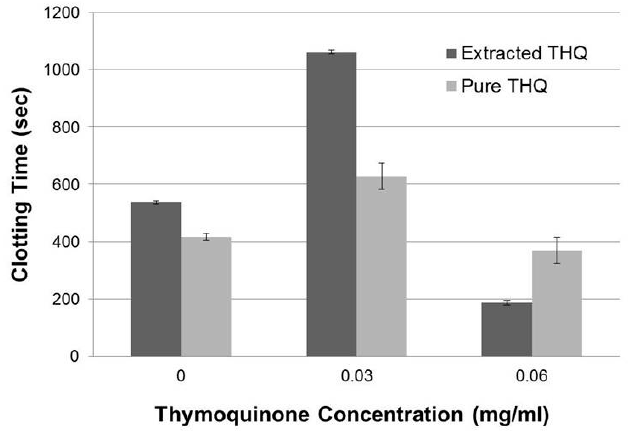
Figure 2. THQ extracted from black seeds and pure THQ exhibit a moderate to slight increase in the basal coagulation time of whole blood. Comparison of the effects of THQ extracted from black seeds and pure THQ on the coagulation time of whole blood measured with TEG assay. Either DMSO or 50% Cremaphore EL:50% EtOH were used as blank controls. Two-way ANOVA test without interaction effects showed that the clotting time is significantly different (F = 9.23; p < 0.01) across the THQ concentrations, and that there was no significant difference (F = 0; p = 0.51) between extracted THQ and pure THQ. Post hoc analysis (Tukey) showed that clotting time for 0.03 mg/mL was significantly greater compared to control ( p < 0.05) and clotting time was not significantly different for 0.06 mg/mL compared to control. The experiments were performed twice in duplicate. Error bars show the standard deviations of the mean values. Table 1. Comparison of coagulation times between USP heparin and Thymoquinone (THQ) by aPTT assay. Final Concentration